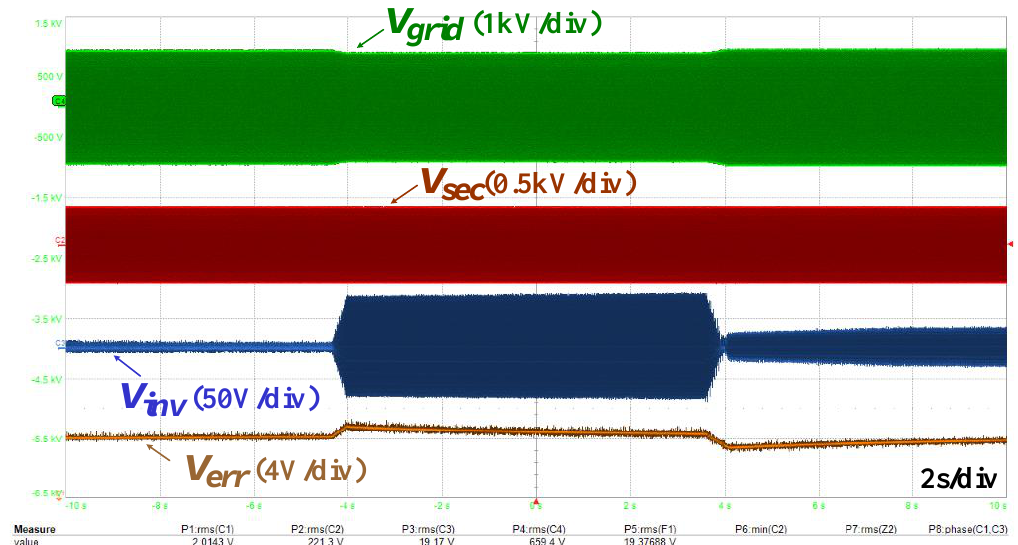
Figure 16. The grid, secondary side, inverter voltage and voltage error under the case 2 condition.